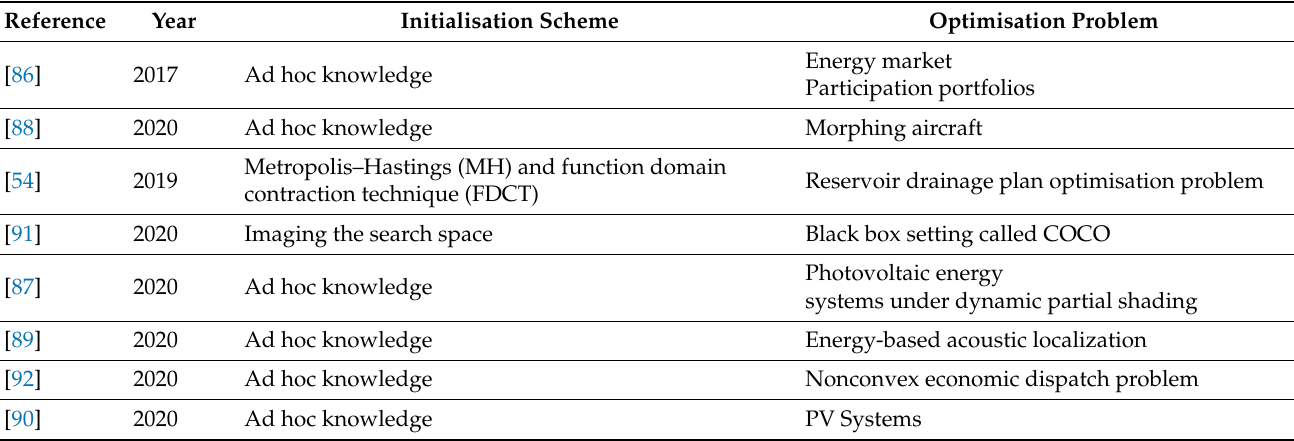
Table 6. Summary of methods based on ad hoc knowledge.